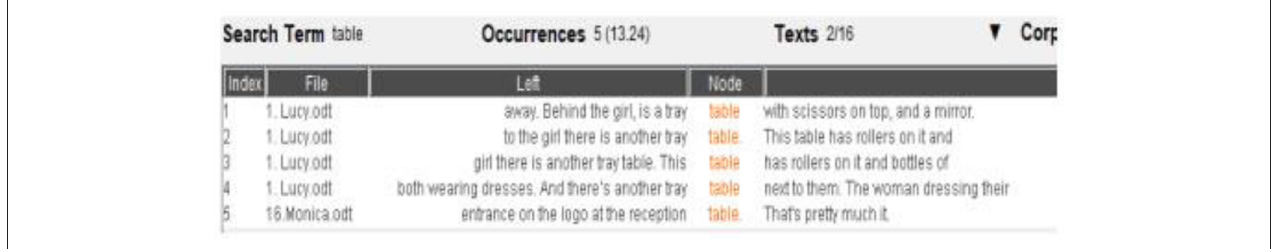
FIGURE 10 | Table